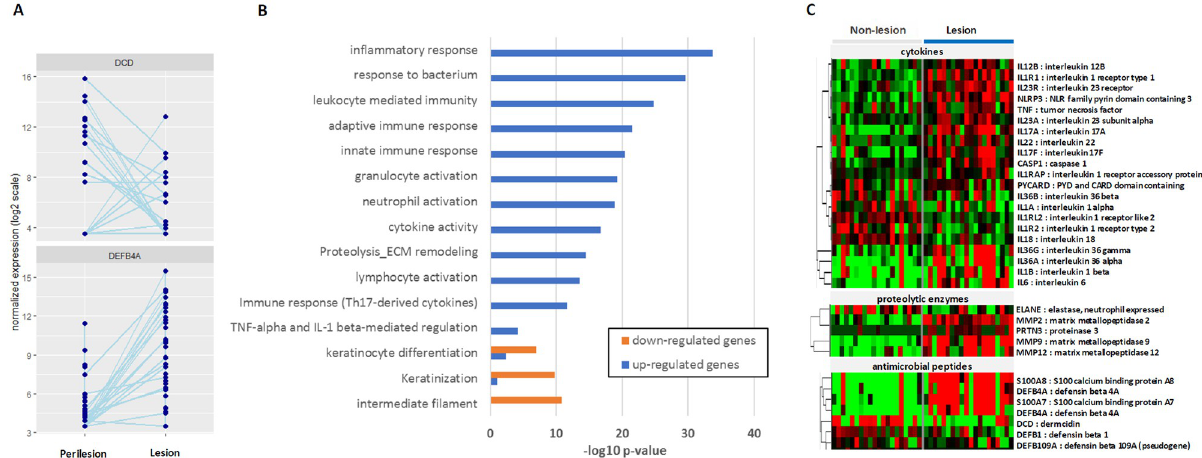
Fig 2. Pathway enrichment analysis and exploration of disease biology. Pathway analysis was performed to characterize the underlying molecular mechanisms driving the observed differences in expression. Antimicrobial peptide DEFB4A was significantly increased in the lesion samples while DCD expression was significantly decreased (C). Upregulated pathways include both adaptive and innate immune response as well as response to bacterium, Th-17, TNF-alpha, and IL-1beta mediated pathways, neutrophil and lymphocyte activation and ECM remodeling. Keratinization and intermediate filament were among the down-regulated pathways (B). Key genes that are part of specific pathways known to be involved in HS disease biology are generally upregulated in lesion samples (C).